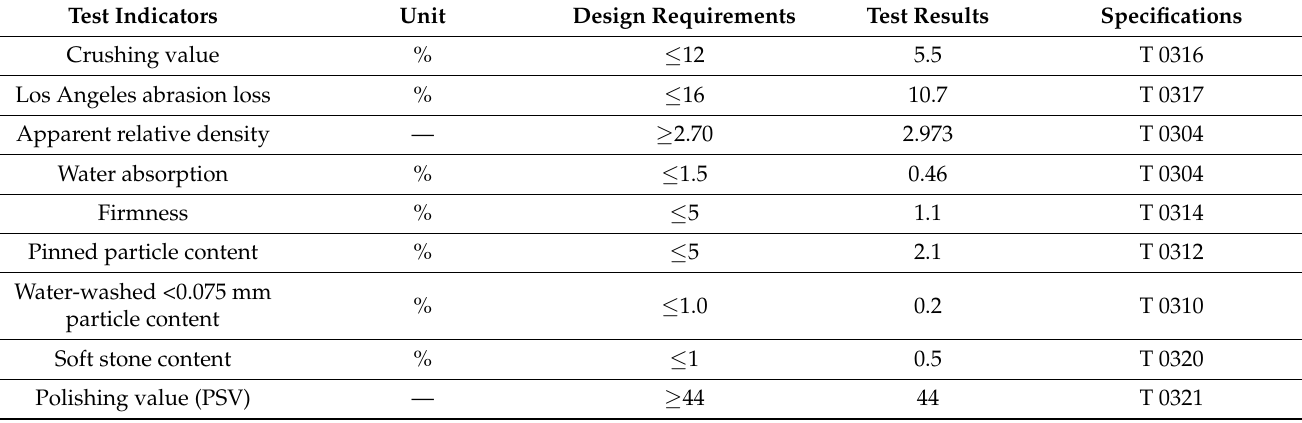
Table 3. Coarse aggregate test results.